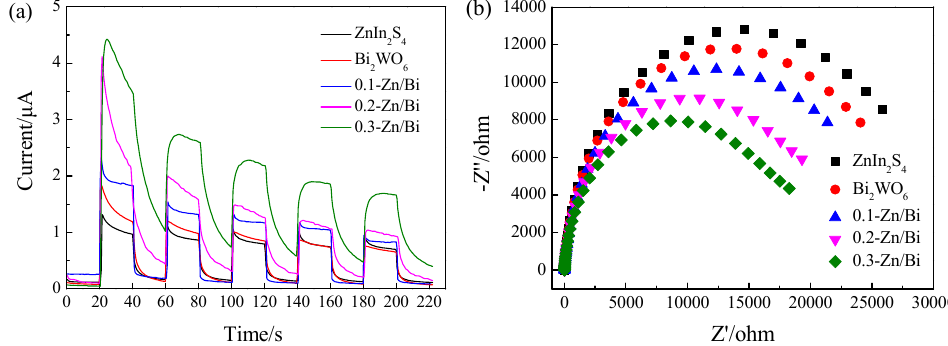
Figure 4. Photoelectrochemical properties of as-prepared photocatalyst: ( a ) Photocurrent-time (I-T) curves; ( b ) EIS plots.